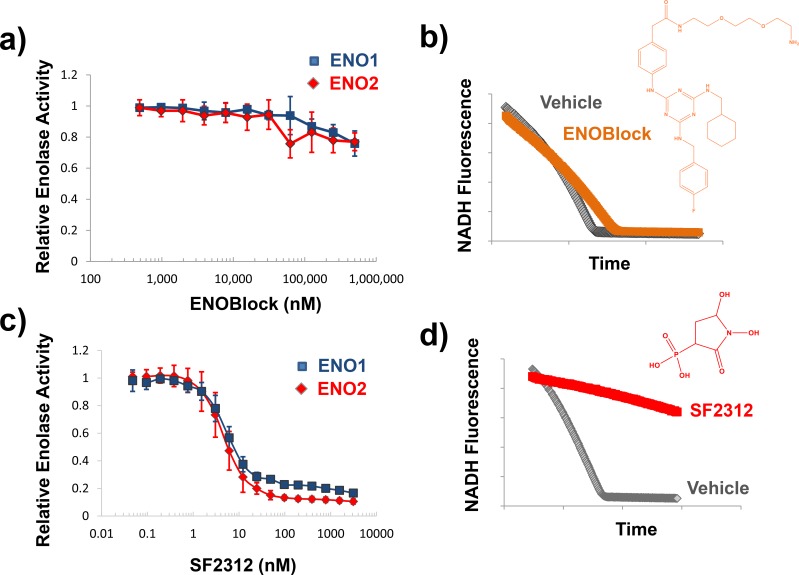
Fluorometric NADH-linked assay for measuring Enolase activity.The effect on ENOblock (a, b) and SF2312 (b, d) on Enolase activity in lysates from the D423 cell line expressing ENO2 (red diamonds) or ENO1 (blue squares) was determined using the NADH-linked assay. Panel b shows a representative trace of NADH fluorescence over time of vehicle control (gray symbols) and 100 μM ENOblock (orange symbols), while Panel d shows traces of vehicle control (gray symbols), with 50 nM SF2312 (red symbols). Panel a and c shows enolase activity normalized to vehicle control and expressed as a function of inhibitor concentration. Each data point represents mean of N = 6 (a) and N = 4 (c) ± S.D.